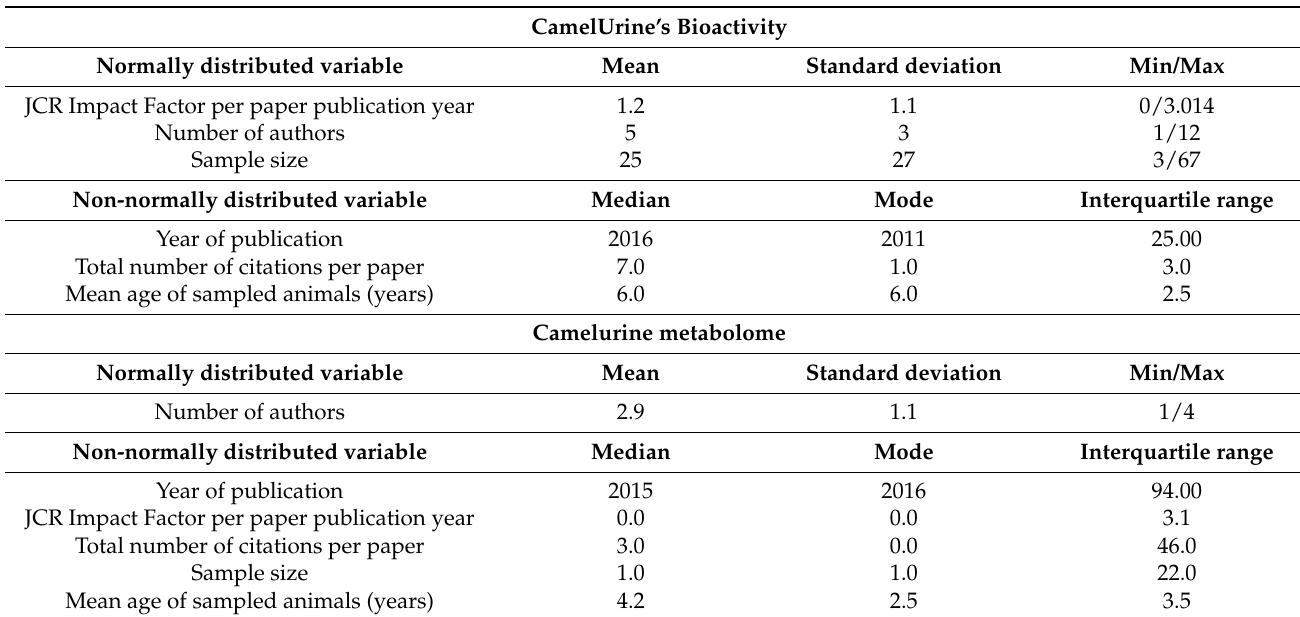
Table 2. Summary statistics for the ordinal and numeric variables.